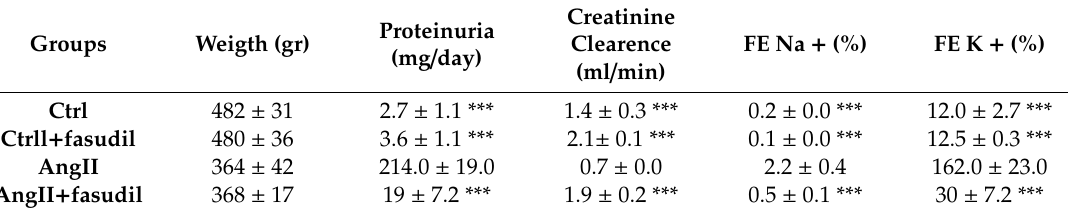
Table 1. Values for weight, proteinuria, creatininuria, creatininemia, creatinine clearance, and fractional excretion (FE) for Na + and K + in the experimental groups. Protein and creatinine were measured to assess renal function; the fractional excretion of sodium and potassium (FENa + , FEK + , [%]) was also determined. Data are expressed as mean ± SE. The di ff erences were evaluated by analysis of variance followed by the Tukey post-hoc test. *** p < 0.001 vs. AngII groups ( n ≥ 4 / all